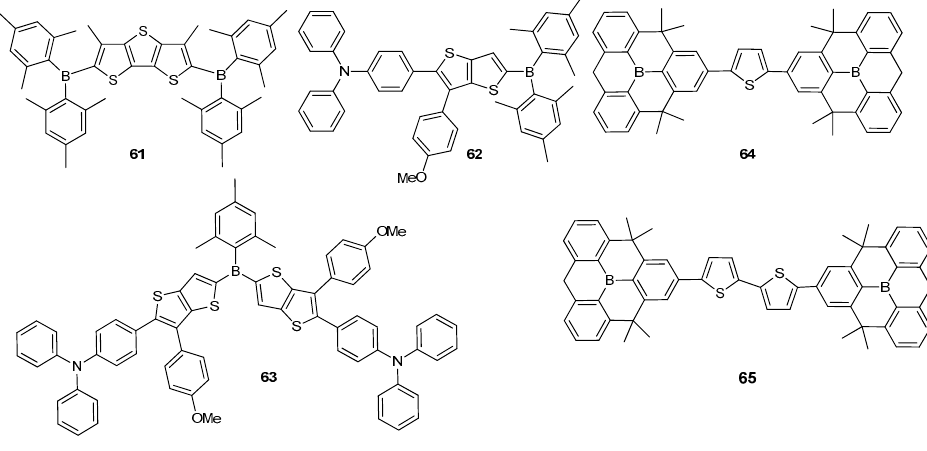
Figure 10. Triarylborane-based materials 61 – 65 .